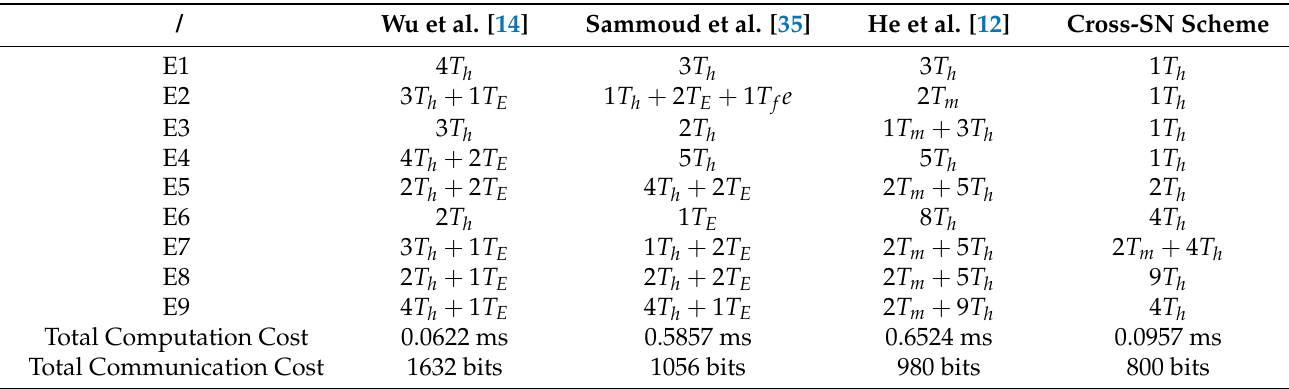
Table 4. Functionality